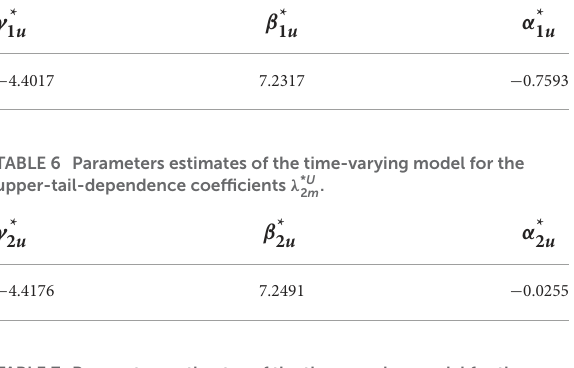
TABLE 7 Parameters estimates of the time-varying model for the upper-tail-dependence coefficients λ U 1 m .